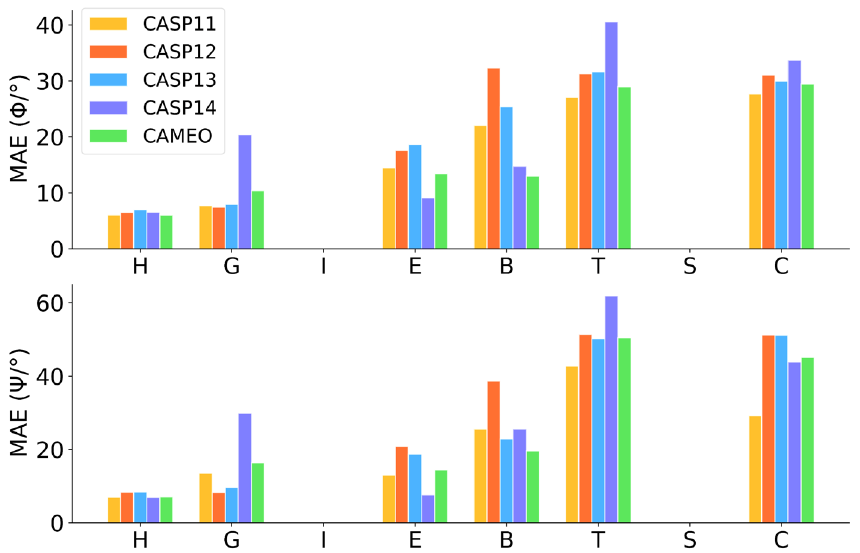
Figure 3. The MAE of the torsion angles ( φ and ψ ) on the 8-class secondary structures for the TFM targets in the CASPs and